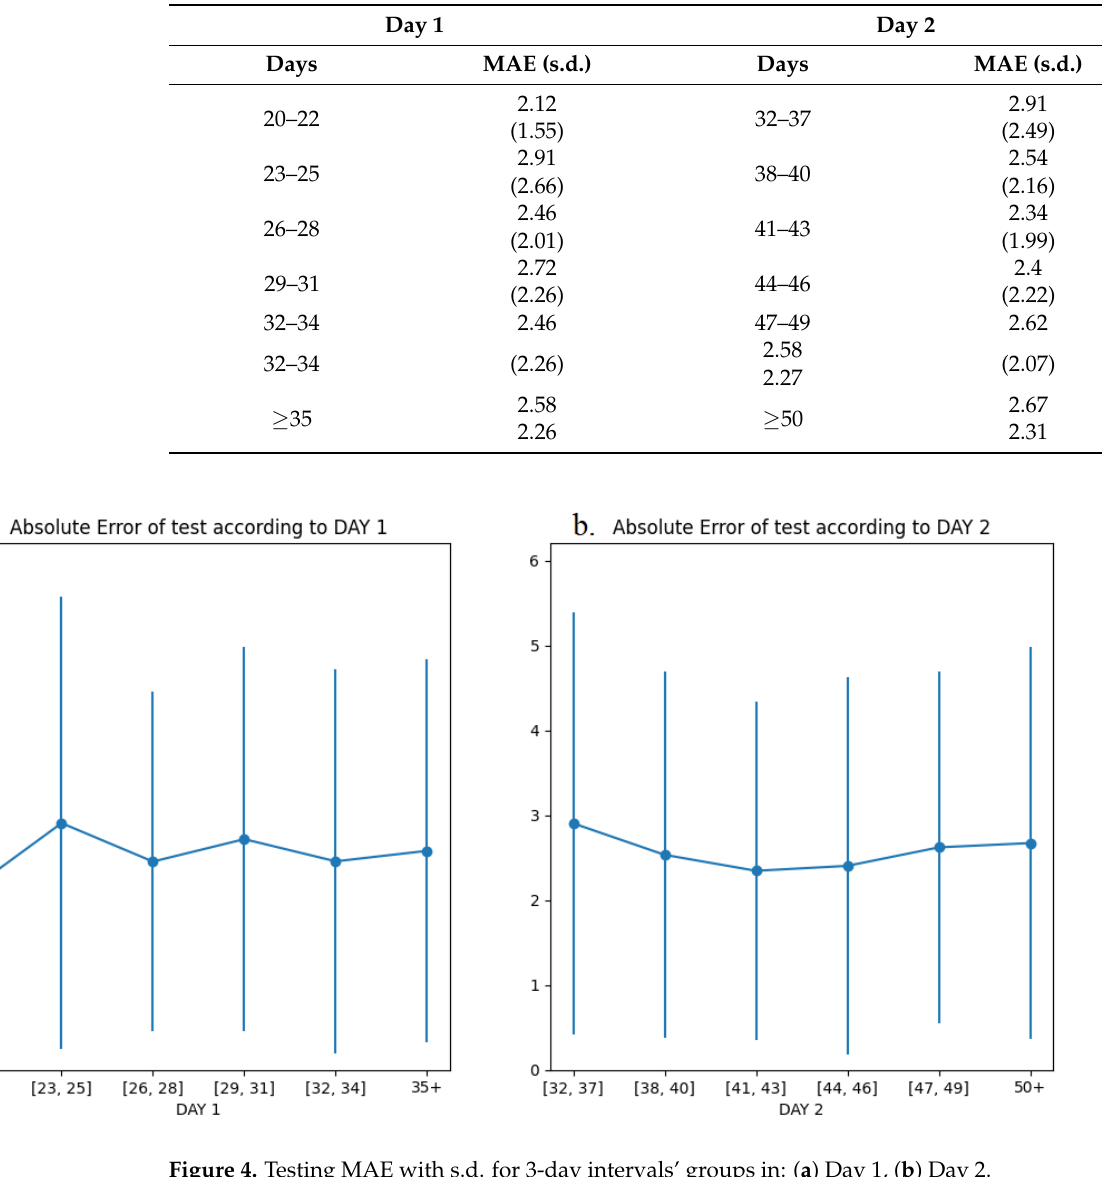
Figure 4. Testing MAE with s.d. for 3-day intervals’ groups in: ( a ) Day 1, ( b ) Day Figure 4. TestingMAE withs.d. for 3- day intervals’ groups in: ( a ) Day 1, ( b ) Day 2.